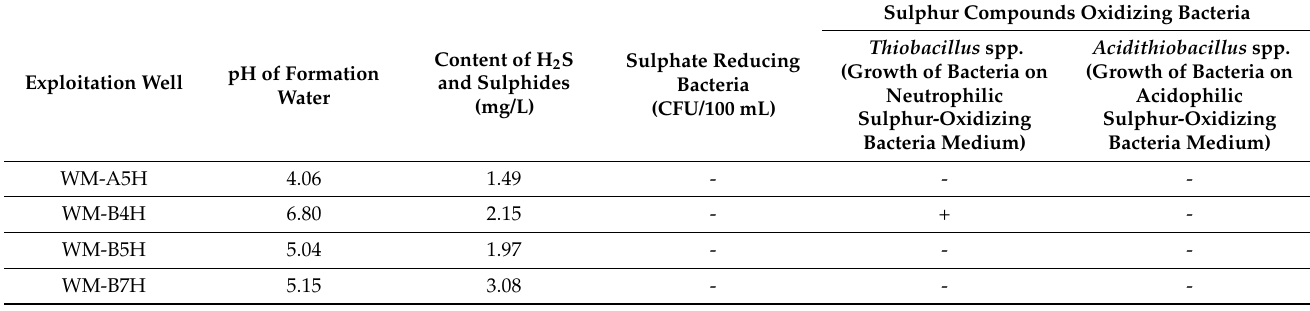
Table 2. The results of microbiological and chemical tests on formation waters collected from Wierzchowice UGS wells—XXII operational cycle